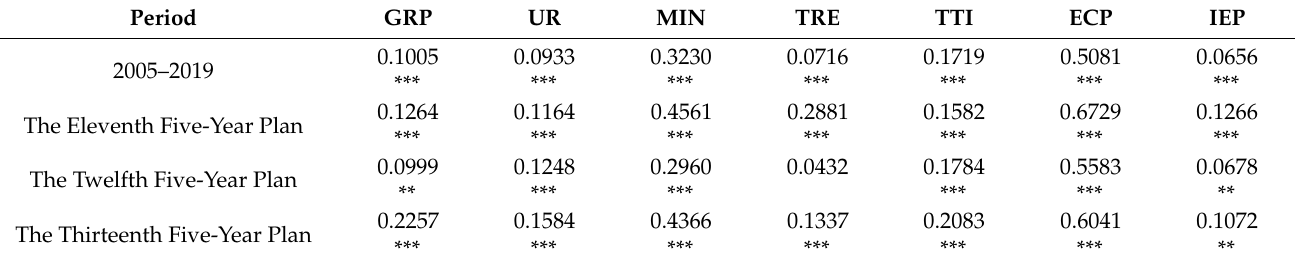
Table 5. Detector results for the influencing factors of tourism carbon emissions